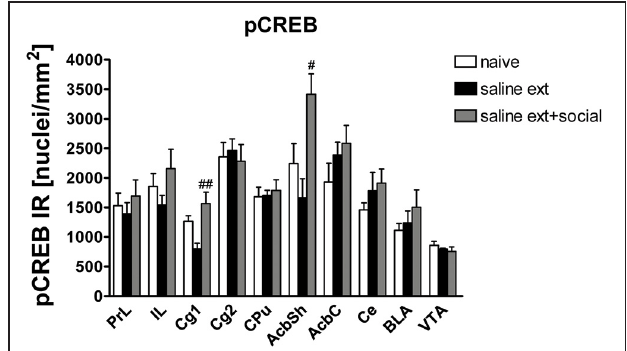
FIGURE 4 | Social interaction increases cocaine CPP reinstatement-associated pCREB expression in nucleus accumbens shell (AcbSh) and cingulated cortex (Cg1). Shown are pCREB positive immune-reactive nuclei per mm 2 of the respective brain area. Shown are group means ± SEM. # P < 0 . 05 and ## P < 0 . 01 compared to saline extinction group. Brain area abbreviations follow the nomenclature of Paxinos and Watson (Paxinos and Watson, 2007).